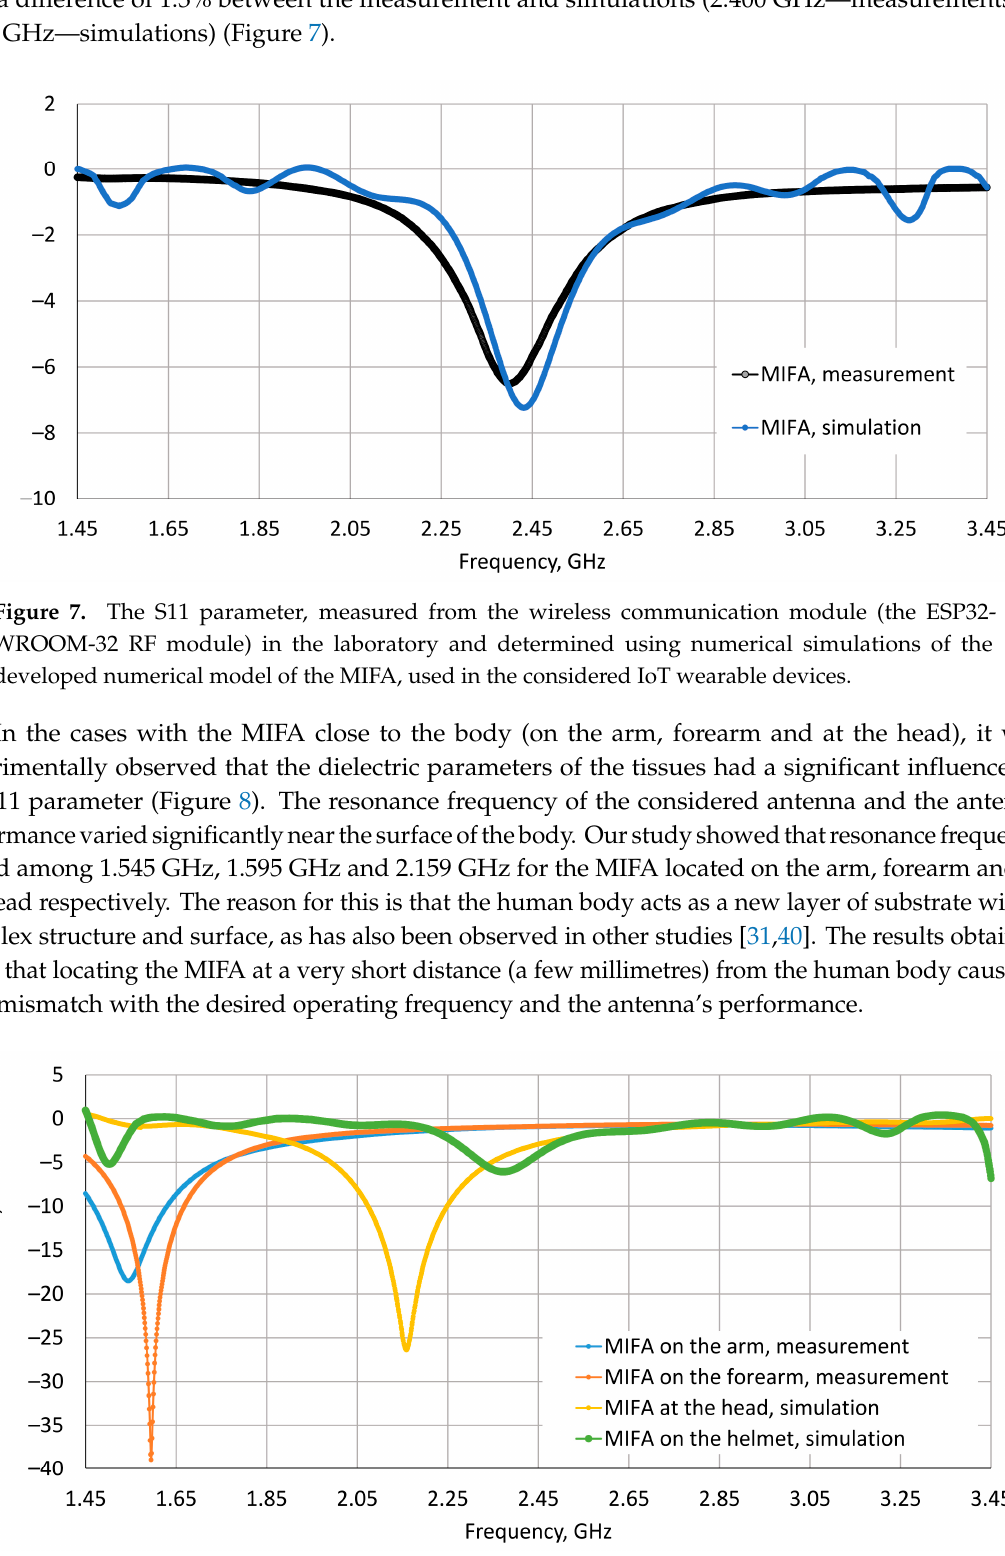
Figure 8. The S11 parameter, measured in the laboratory and determined using numerical simulations of the developed numerical model of the wireless communication module (RF module) used in IoT wearable devices located near various parts of the worker’s body.